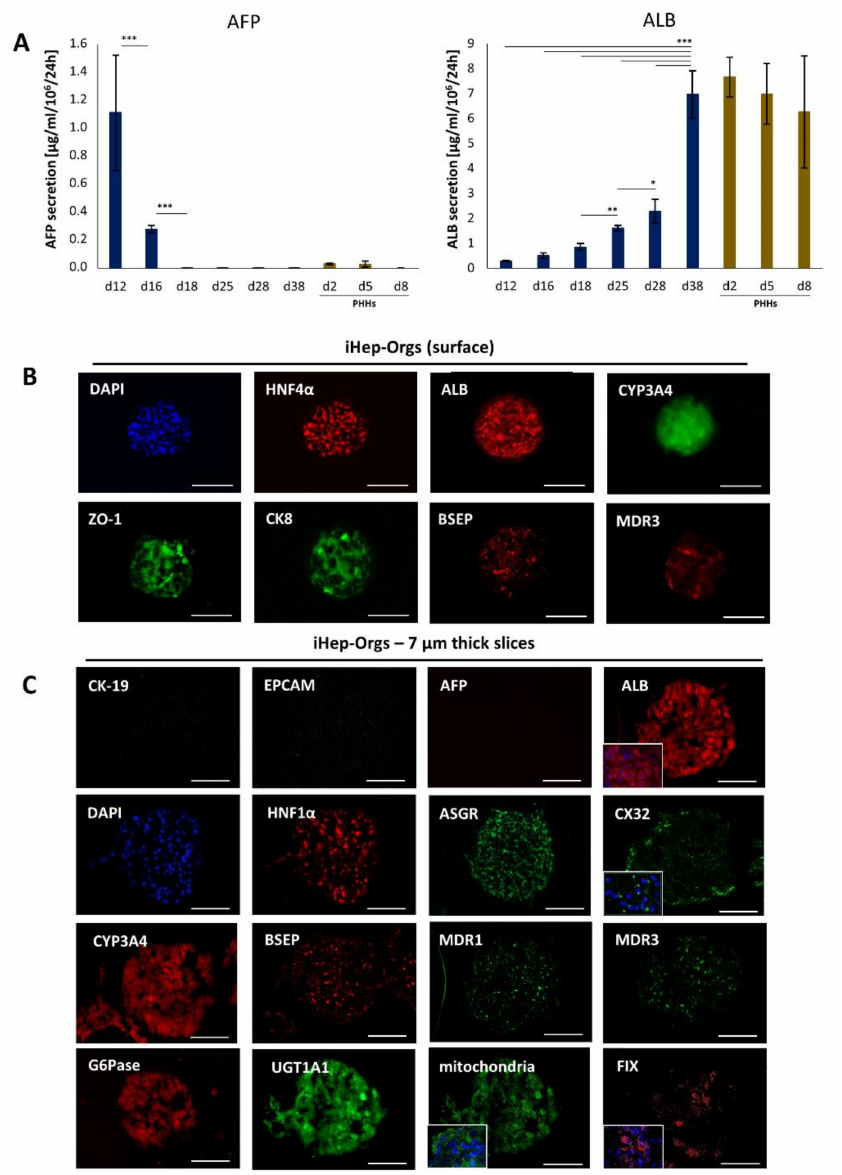
Figure 2. Immunofluorescence staining of iHep-Orgs at the final stage of the differentiation. ( A ) ELISA quantification of AFP and ALB secretion of iHep-Orgs (blue bars) and PHH-Orgs (brown bars). Histograms represent mean ± SD ( n = 16). *** indicates p < 0.001; ** indicates p < 0.01; * indicates p < 0.05 ( B ) Whole iHep-Orgs immunostained for HNF4 α , ALB, CYP3A4, ZO-1, CK-8, BSEP, and MDR3. Nuclei are stained with DAPI. Scale bars = 200 µ m. ( C ) Sections (7 µ m thick) of iHep-Orgs immunostained for CK-19, EPCAM, AFP, ALB, HNF1 α , ASGR, CX32, BSEP, MDR1, MDR3, CYP3A4, UGT1A1, G6Pase, mitochondria, coagulation factor IX (FIX). Nuclei are stained with DAPI. Scale bars = 100 µ